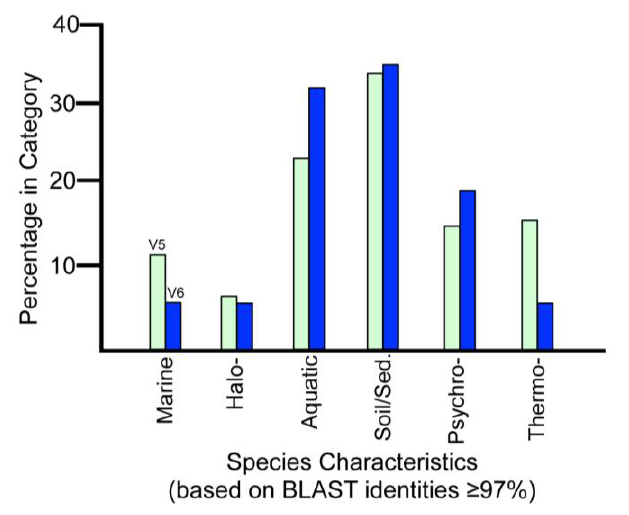
Figure 2. Comparisons of percentages of sequences according to characteristics of the closest species. Bars represent the percentages of sequences in V5 (green bars, N = 338) and V6 (blue bars, N = 38) that could be categorized with sequence identities (cid:149)(cid:28)(cid:26)(cid:8)(cid:3) (cid:87)(cid:82)(cid:3) NCBI sequences. Halo- = halophilic or halotolerant; Sed. = from lake or ocean sediments; Psychro- = psychrophilic or psychrotolerant; Thermo- = thermophilic or